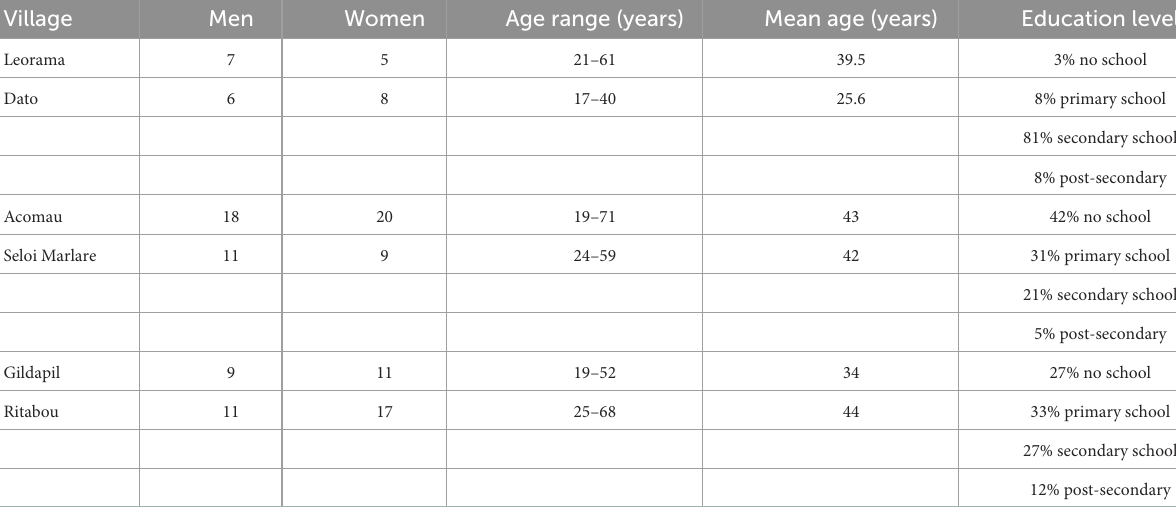
TABLE 1 Gender, ages and education of farmer respondents. Village